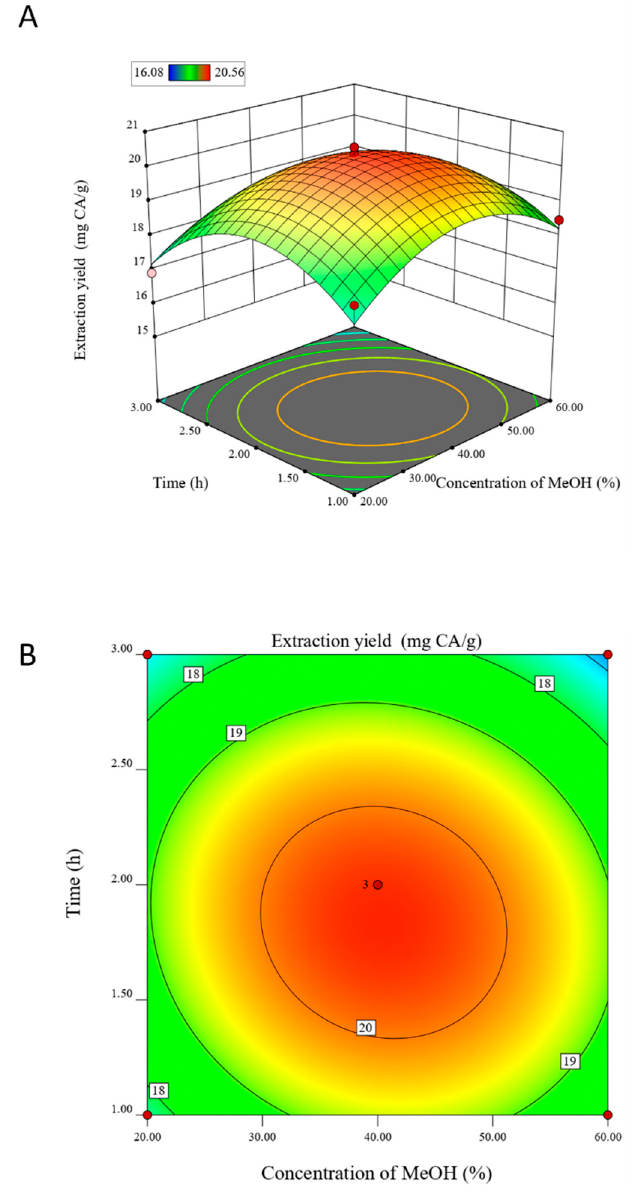
Figure 1. Response surface analysis based on solvent and time. ( A ) is the response surface graph and ( B ) is the corresponding contour graph.